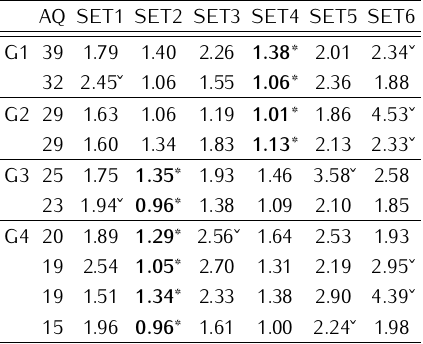
Table 6. Initial success time for each force